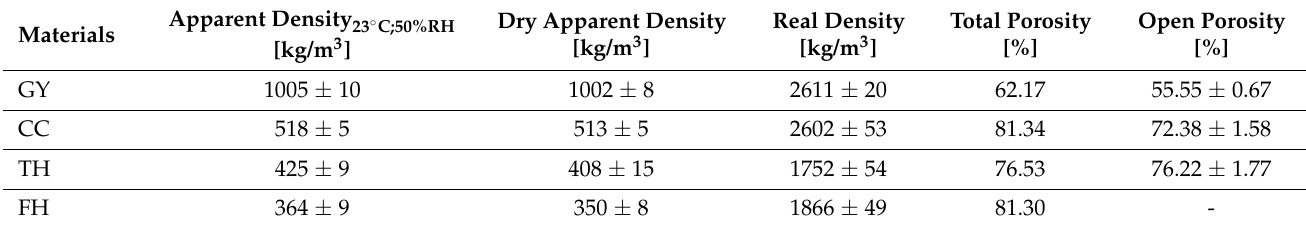
Table 5. Mean values and standard deviations of densities [kg/m 3 ] and total and open porosities [%] of the studied